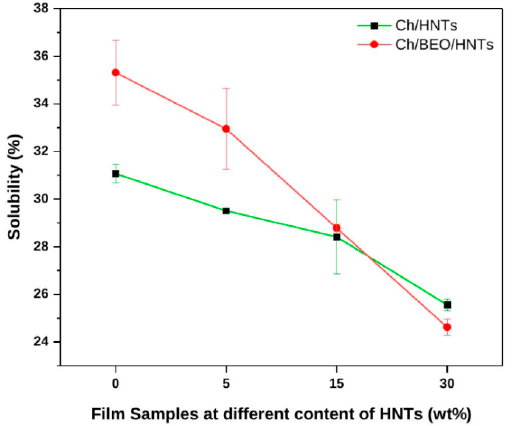
Figure 5. Solubility of Ch films formulated with HNTs and BEO.